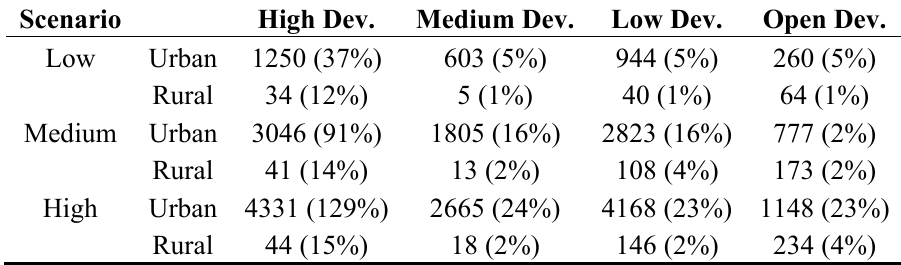
Table 5. Summary of growth in each developed land cover category in each future scenario expressed as total new hectares and percent increase from the USGS NCLD 2006